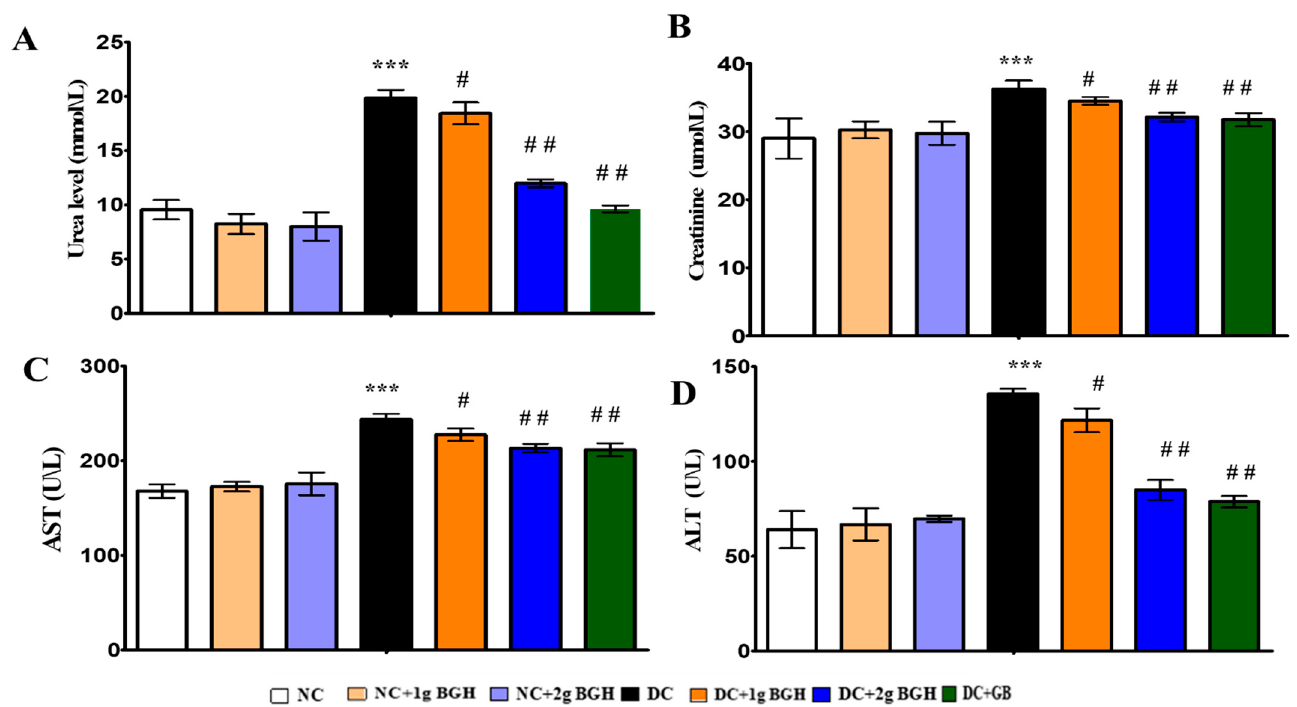
Figure 3. Bar charts showing the effect of BGH on liver and kidney functional markers: ( A ) Urea levels, ( B ) Creatine levels, ( C ) Aspartate aminotransferase (AST) levels, ( D ) Alanine aminotransferase (ALT) levels. The results were collected from six separate rats within every treatment group and were reported as a mean ± S.E.M. *** p < 0.001 vs. NC; # p < 0.05; ## p <